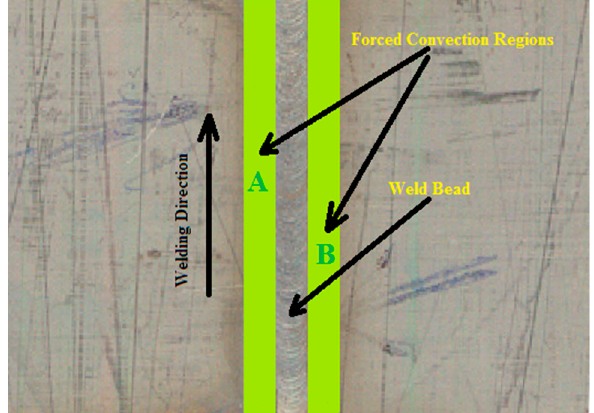
Figure 4. Region A and B indicates the forced convection.